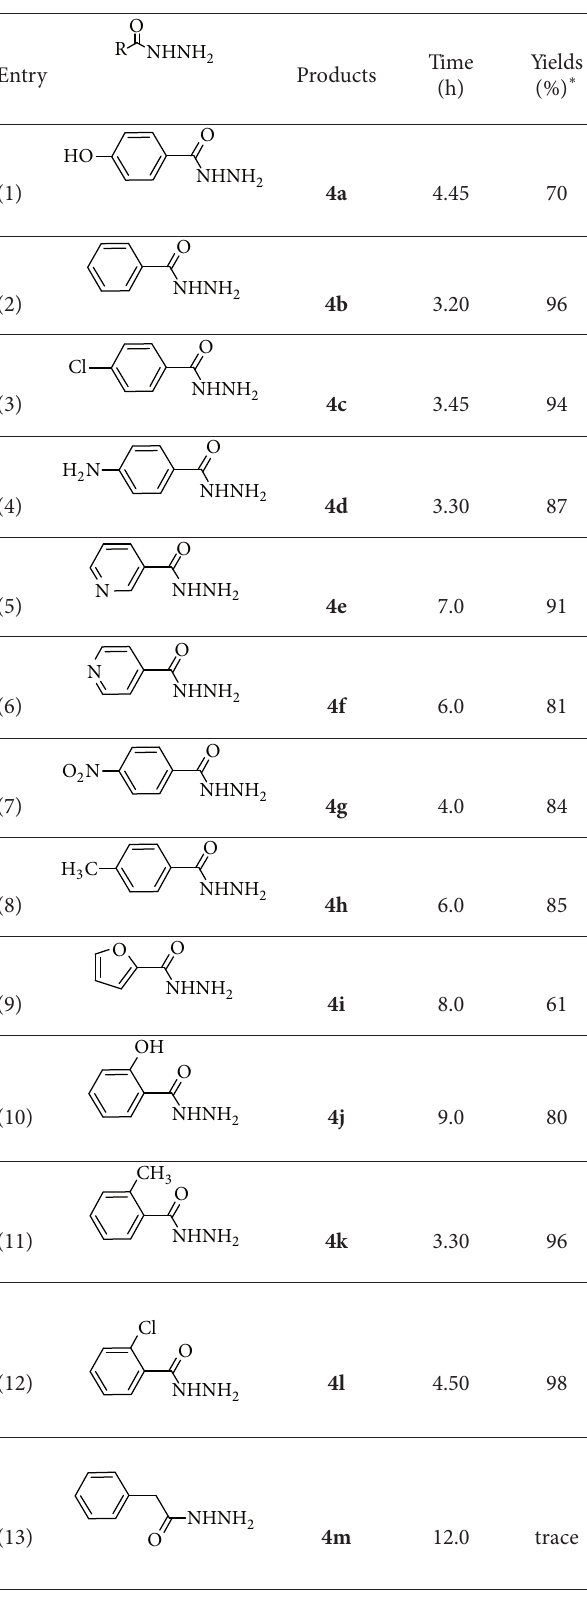
T 1: Ring closure of substrates as a function of solvent. T 2: Synthesis of 5-substituted 1,3,4-oxadiazole-2-thiols 4 in